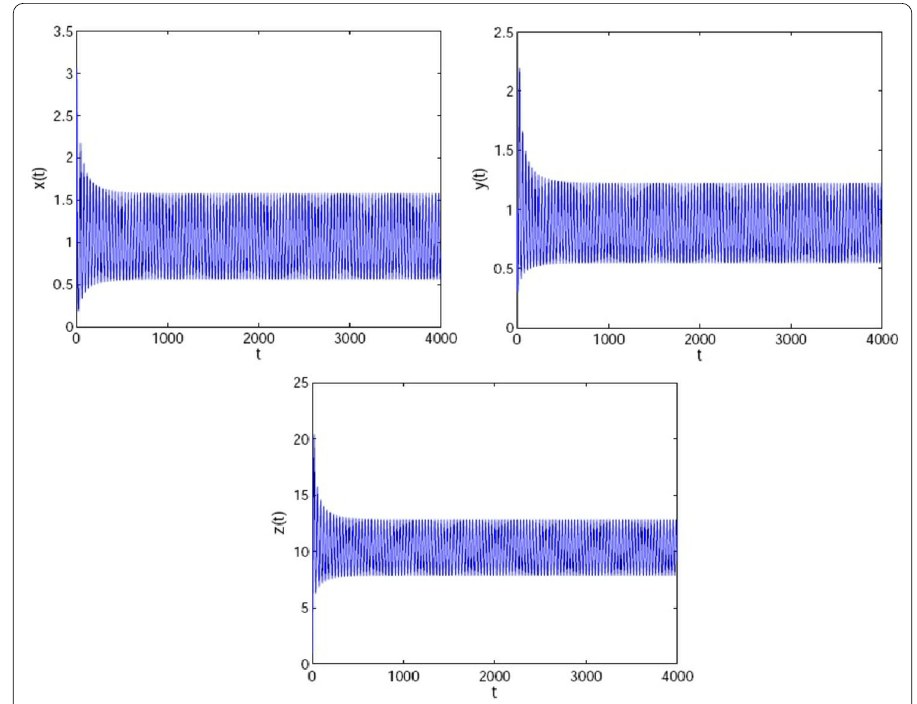
Figure 3 A Hopf bifurcation occurs when τ = 7 > τ 0 = 6.834, which means that system (31) is unstable